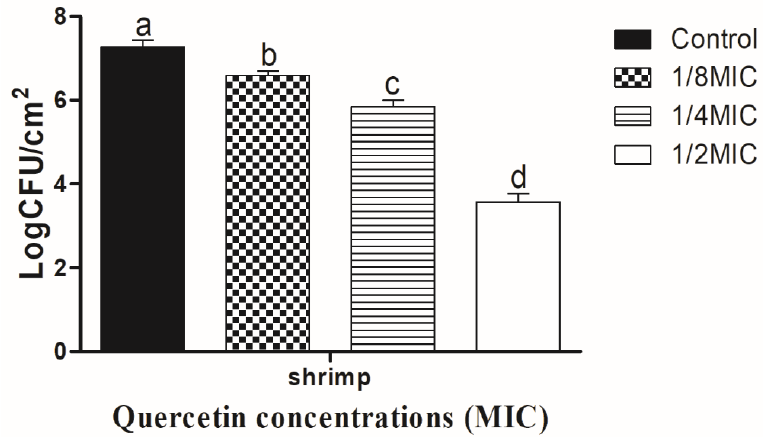
Figure 3. Inhibition of Vibrio parahaemolyticus biofilm formation (24 h) on shrimp surfaces by sub-MICs of quercetin (µg/mL). Data represented as mean ± SEM of three independent replicates. a–d Values with different letters differ significantly by Duncan’s multiple-range test ( p < 0.05).